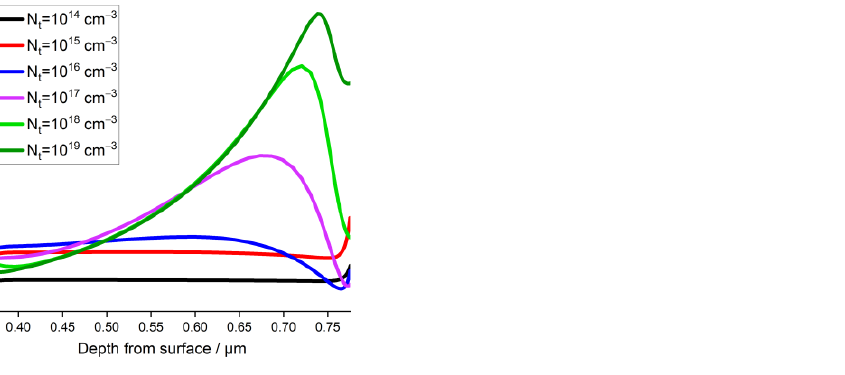
Figure 7. Effect of the absorber layer defect density on the recombination rate with depth from the surface.